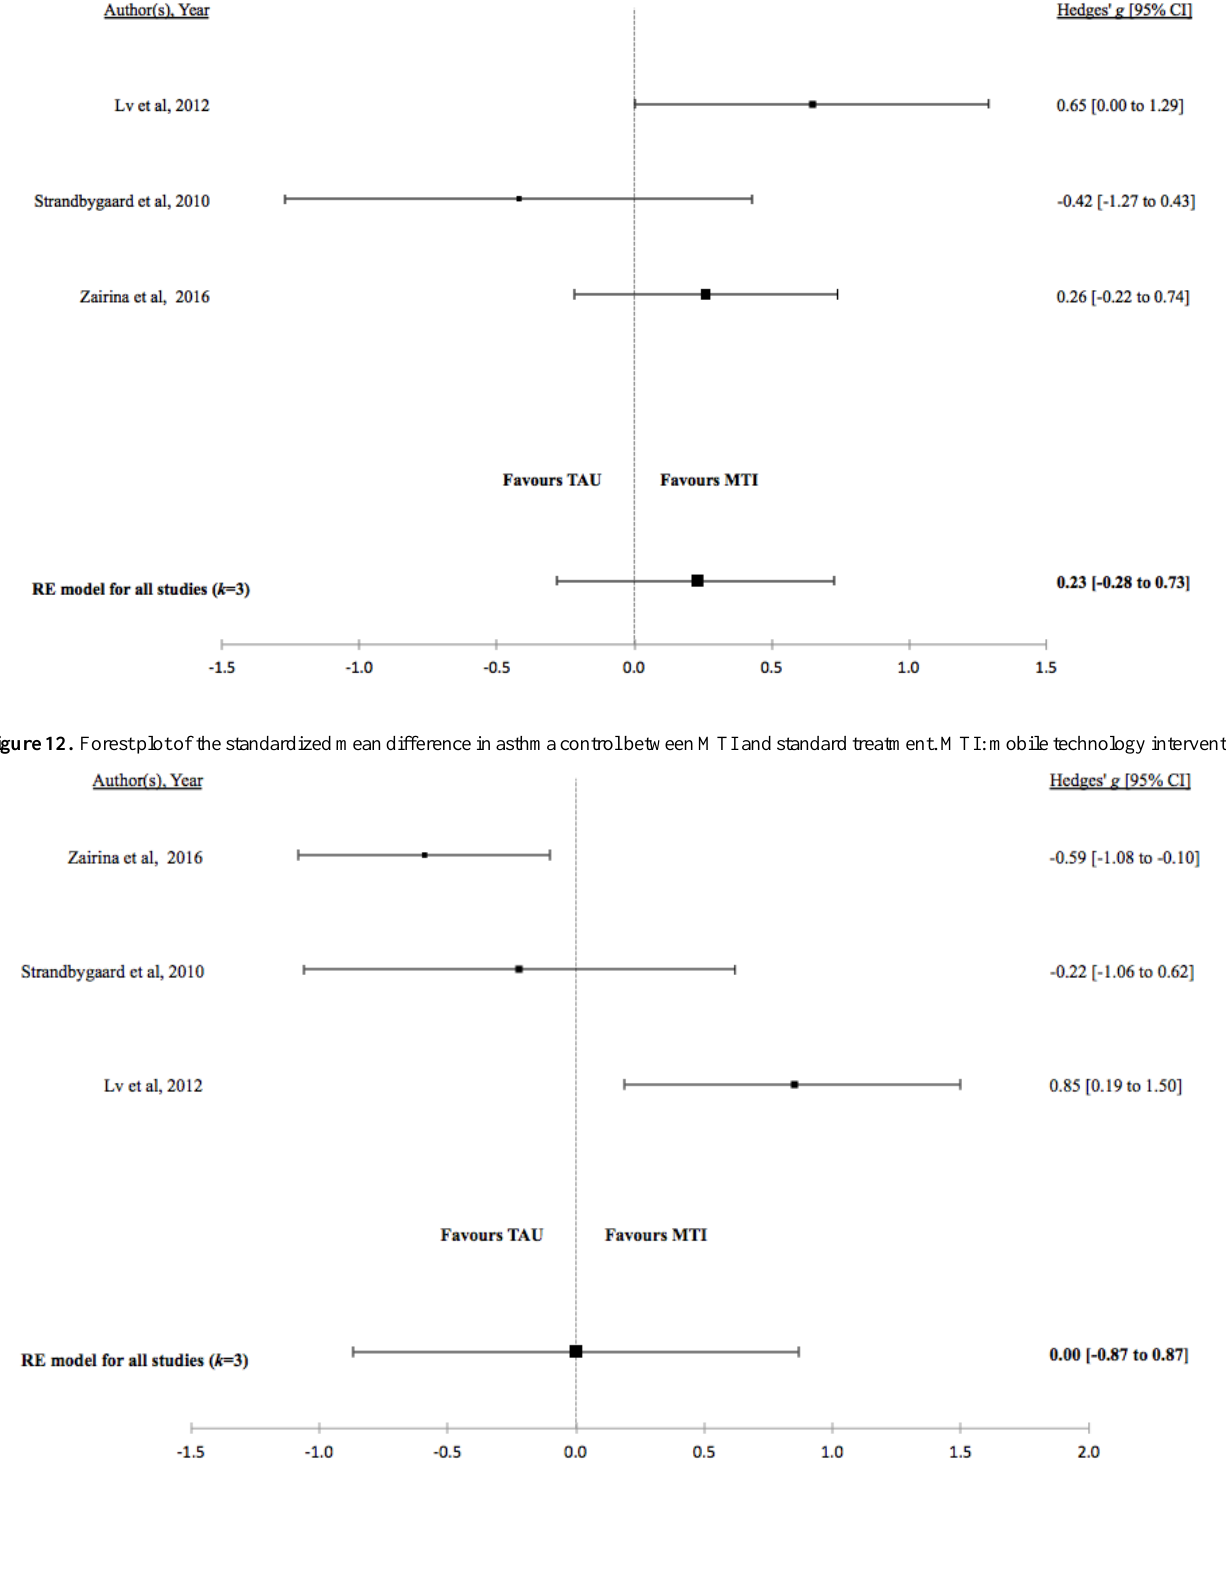
Figure 11. Forest plot of the standardized mean difference in lung function between MTI and standard treatment. MTI: mobile technology intervention.